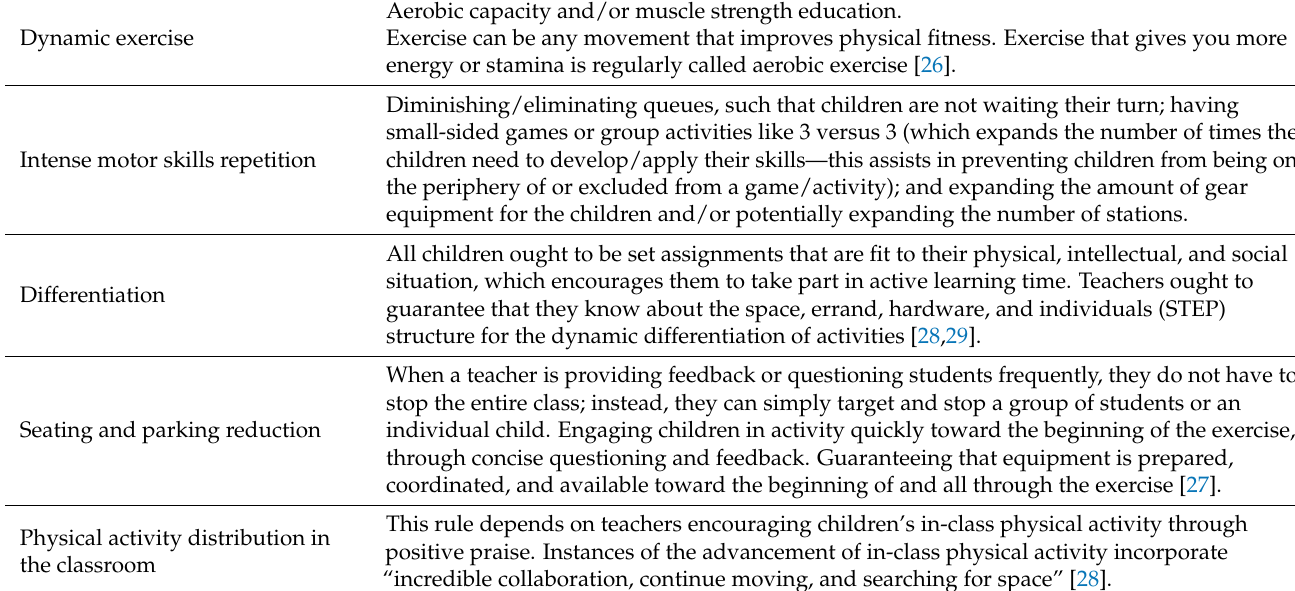
Table 1. Dynamic exercise, intense motor skills reiteration, differentiation, seating and parking reduction, and physical activity distribution in the classroom (DIDSFA) model—expanding dynamic learning time in primary physical education.